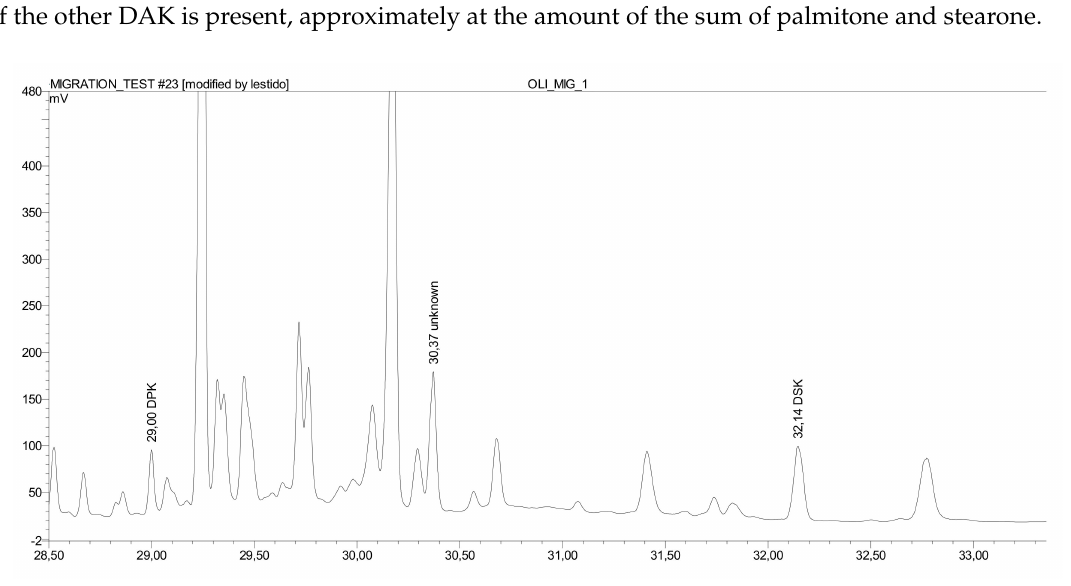
Figure 5. GC-FID chromatogram of the extract of migration in olive oil with palmitone at the RT 29.00 min, another DAK isomer at the RT 30.37 min, and stearone at the RT 32.14